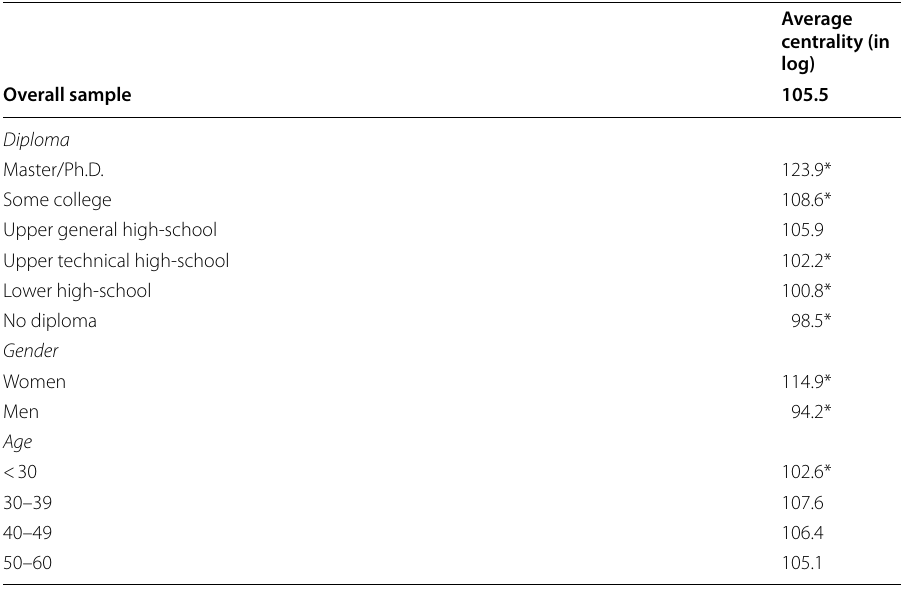
The asterisk indicate the significance of differences in mean compared to overall average